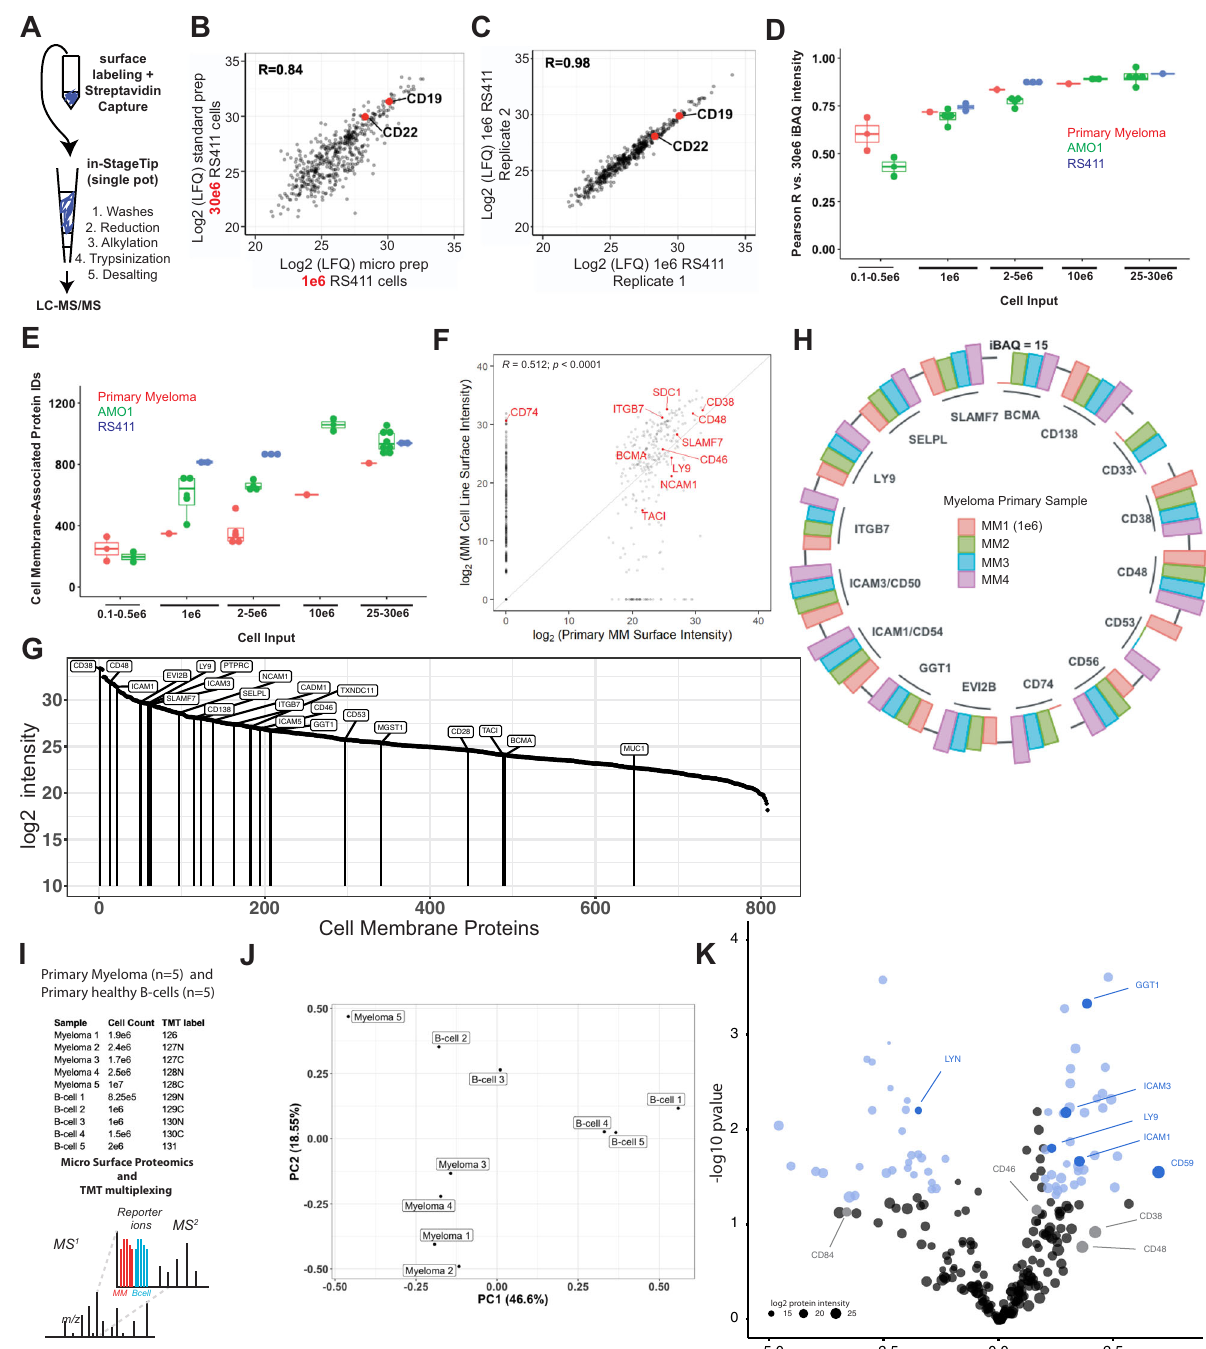
601 membrane-associated proteins (Fig. 6D, E, Supplementary Data 9), with good reproducibility against the macro prepped 30e6 sample (average R = 0.693) and between 1e6 and 3e6 inputs ( R = 0.85) (Fig. 6D, Supplementary Fig. 9A, B). We therefore attempted to apply our micro-CSC method to primary myeloma plasma cells, using cells obtained from four patient bone marrow aspirates via CD138 + magnetic bead isolation. In three cases we isolated a typical yield of ~3e6 – 5e6 plasma cells; however, in sample MM1, with a very rare malignant pleural effusion, we were able to obtain 50e6 cells. This allowed us to perform a titration experiment, testing the micro method on primary myeloma cells across a range of inputs, 25e6, 10e6, 5e6, 1e6, 0.5e6,